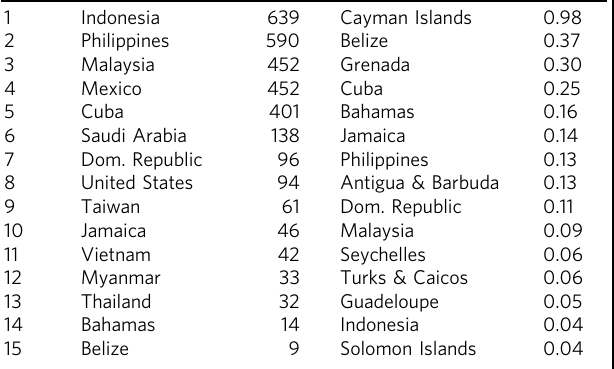
Table 1 Countries that receive the most fl ood protection bene fi ts from reefs